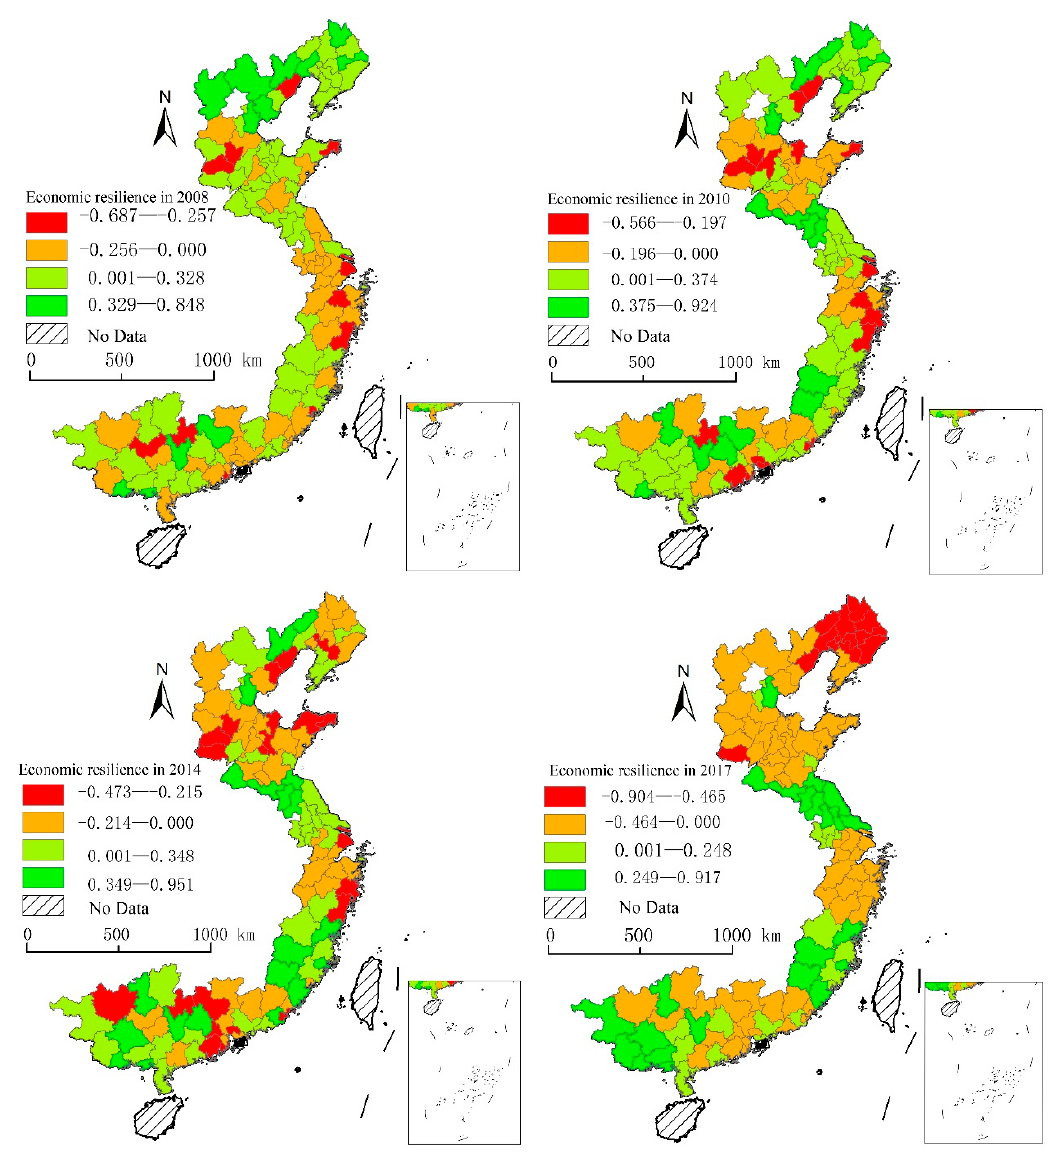
Figure 4. Economic resilience of coastal areas in China.